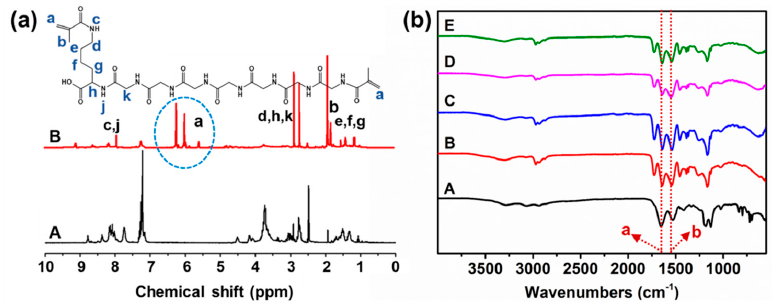
Figure 3. ( a ) 1 H NMR of (A) the peptide GGGGGGGK (black line) and (B) the peptide-based bis-acrylate (red line). ( b ) FTIR of the hydrogels (A: peptide-based bis-methacrylate; B: Gel-1; C: Gel-2; D: Gel-3; E: Gel-4). Peak a: 1650 and 1540 cm –1 , Peak b: 1540 cm –1 . Table 1. The feed ratios of the peptide-based bis-acrylate/AAc hybrid hydrogels. Component Gel-1 Gel-2 Gel-3 Gel-4 Peptide-based bis-acrylate (mg)